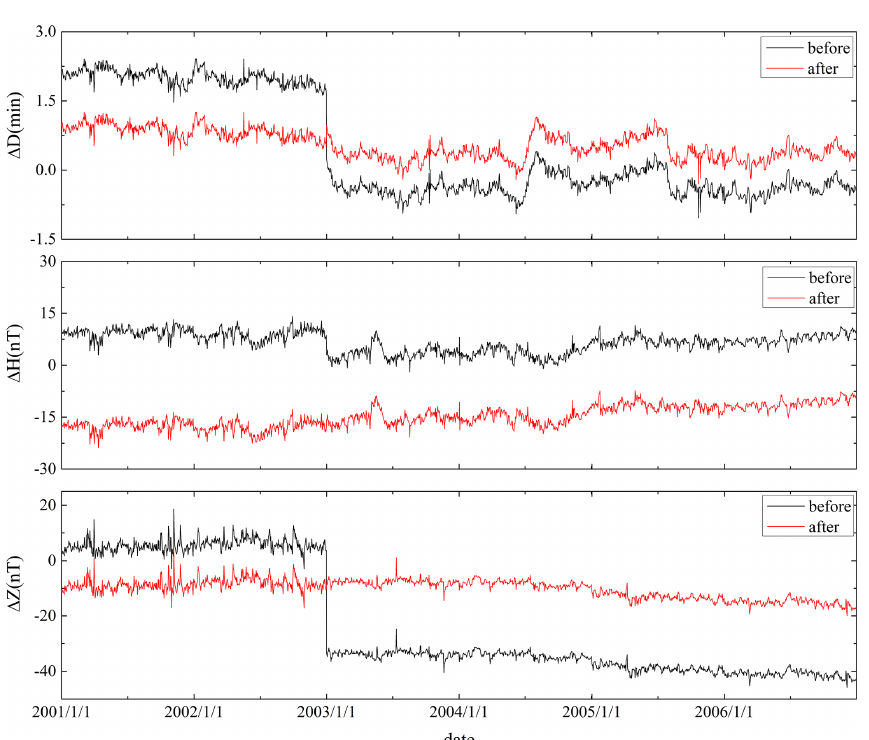
Figure 13. Plot of difference between the SSH and COM before and after correction.